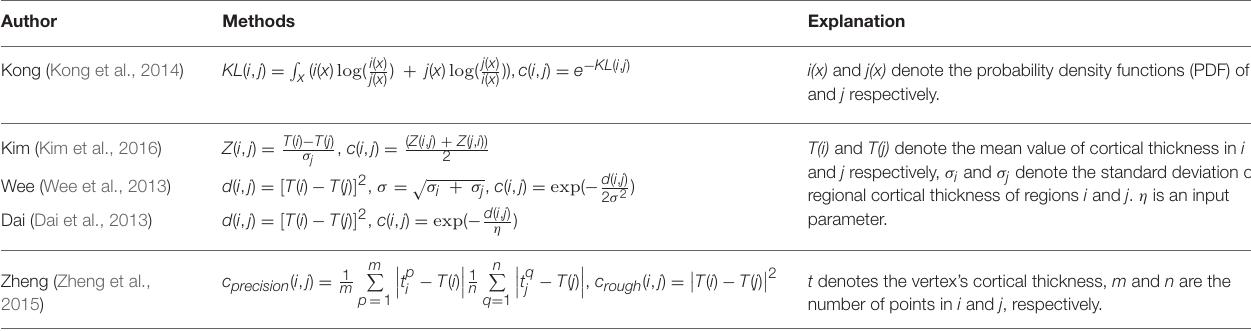
TABLE 3 | The methods of constructing individual morphological brain networks in previous